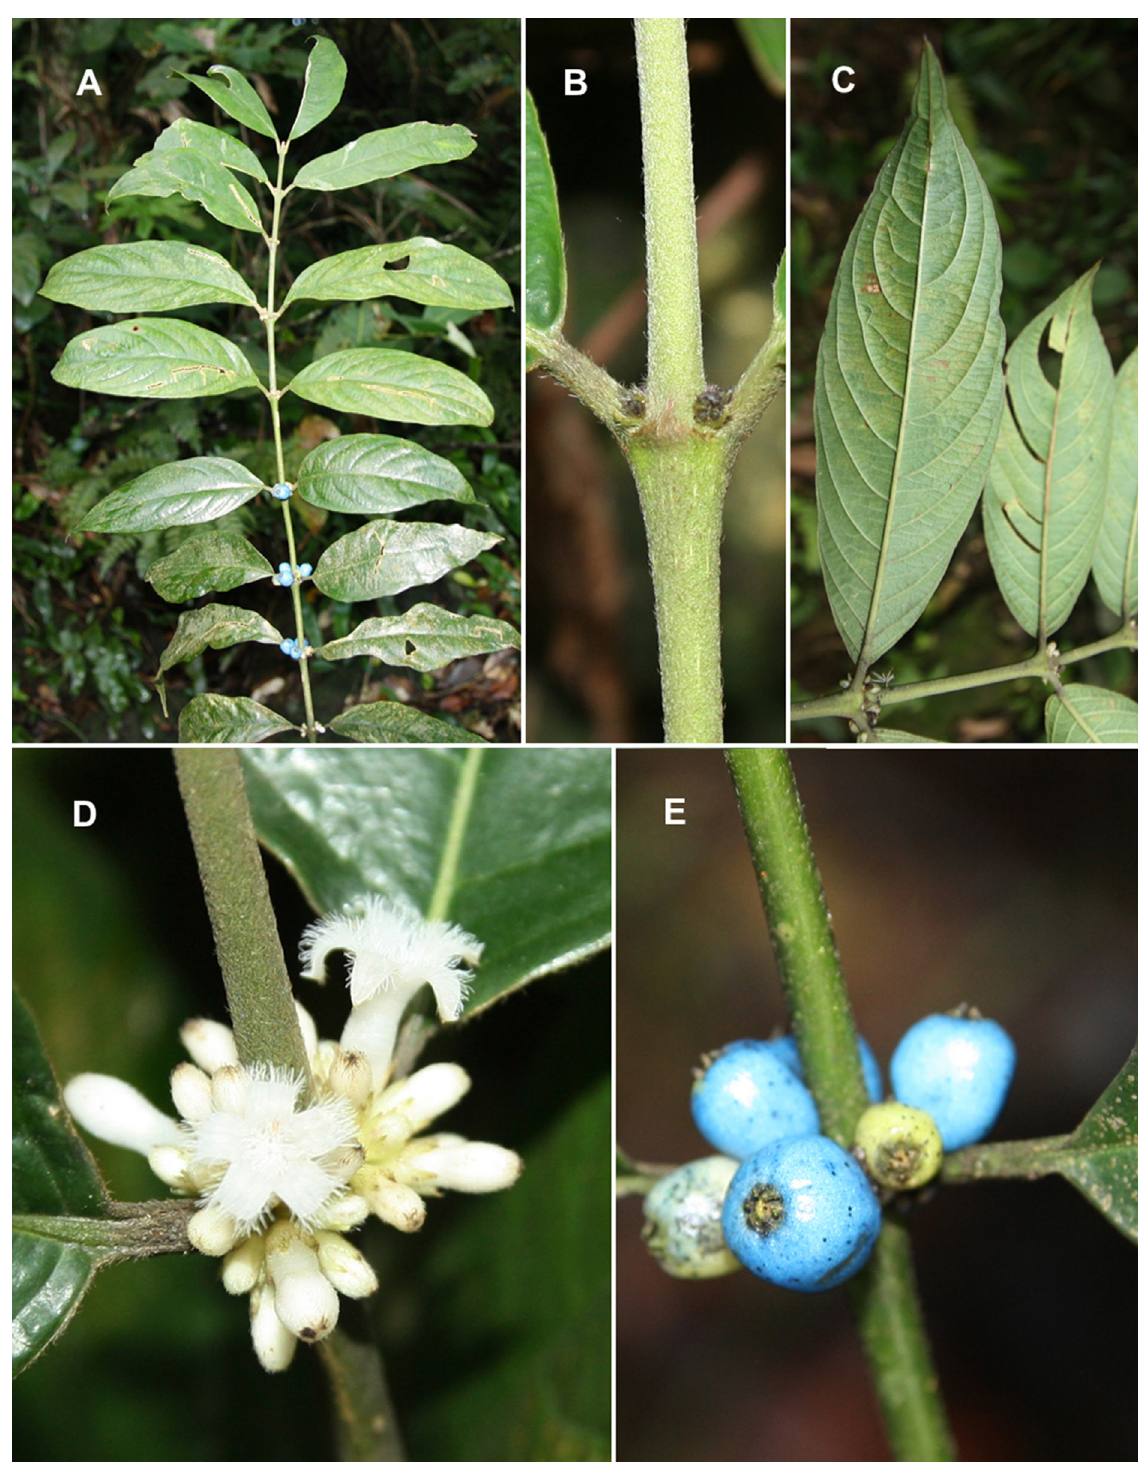
Fig. 3. Lasianthus formosensis Matsumura. A . Fruiting branch. B . Stipule. C . Abaxial leaf surfaces. D . Close-up of inflorescences and flowers. E . Fruits. Photos by Van-Son Dang on 17 Nov.